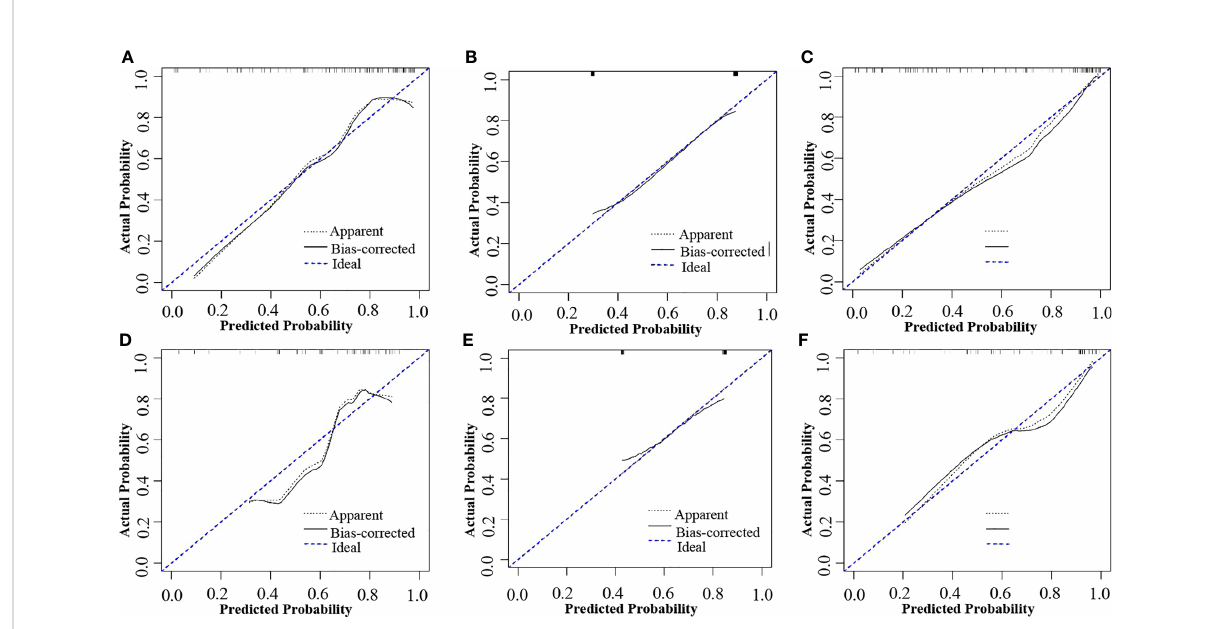
FIGURE 5 Calibration curves of the combined model, radiomics model and reported status model in the training and validation cohorts, respectively. (A) Calibration curve of the radiomics model in the training cohort. (B) Calibration curve of the MRI-reported status model in the training cohort. (C) Calibration curve of the combined model in the training cohort. (D) Calibration curve of the radiomics model in the validation cohort. (E) Calibration curve of the MRI-reported status model in the validation cohort. (F) Calibration curve of the combined model in the validation cohort. The black dotted line and the black line closer to the blue dotted line indicates a better calibration.